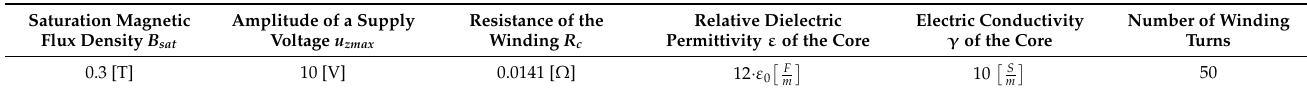
Table 1. The field model